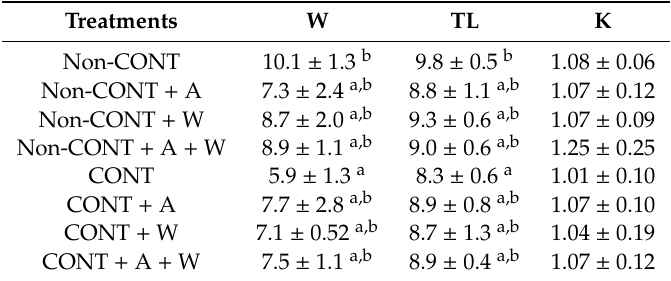
Table 4. Total weight (W; g), total length (TL; cm), and Fulton’s condition index (K) of specimens from all treatments at the end of Hg exposure phase.